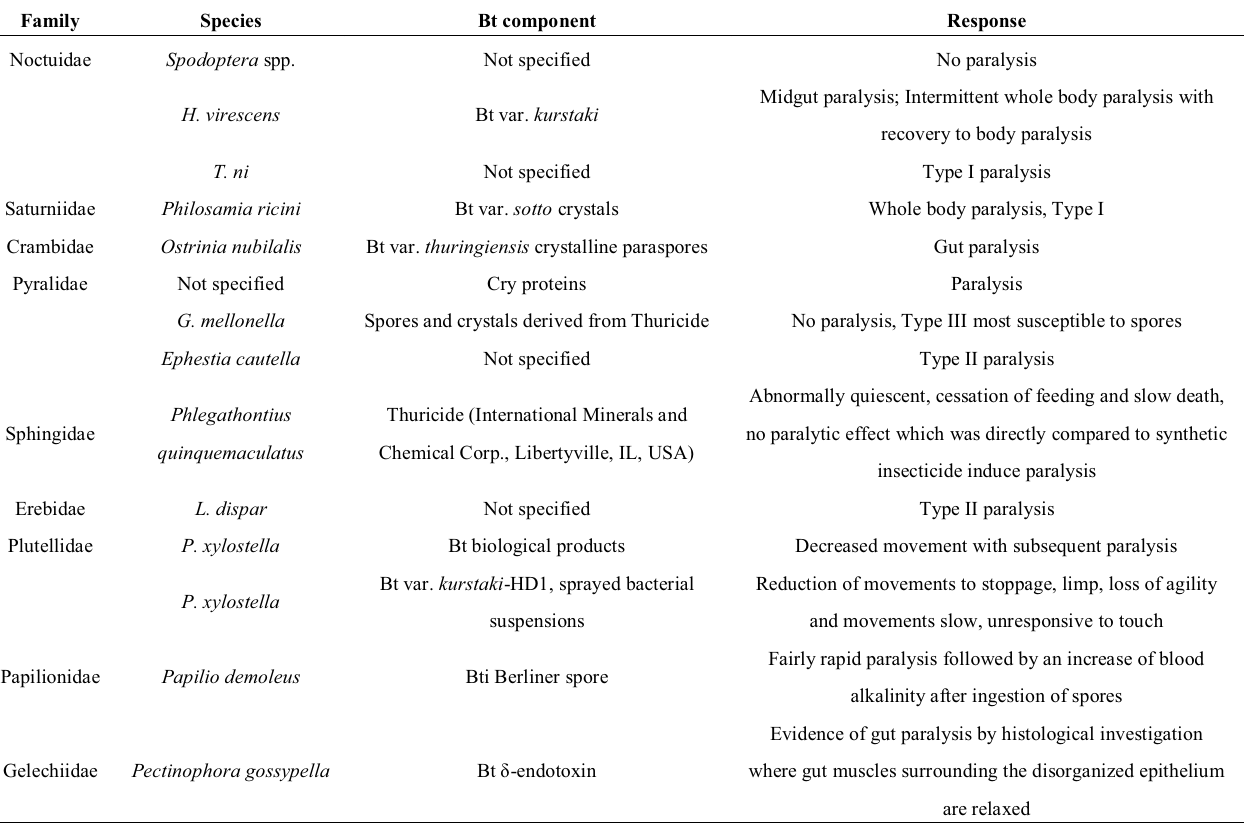
Table 2. Paralytic effects of ingested Bt on various lepidopteran families and